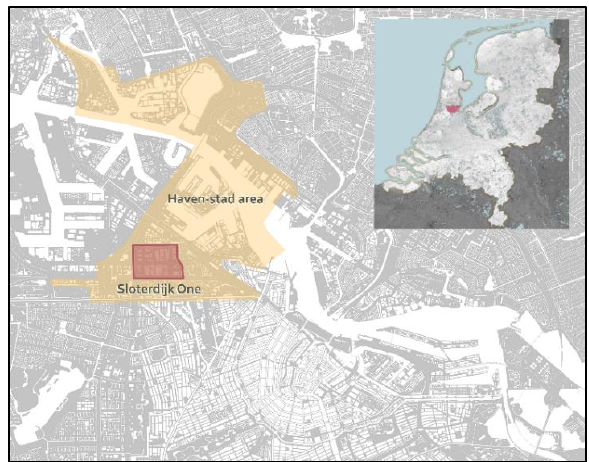
Figure 1. The “Sloterdijk One” case study area, located in the western part of the city of Amsterdam, The